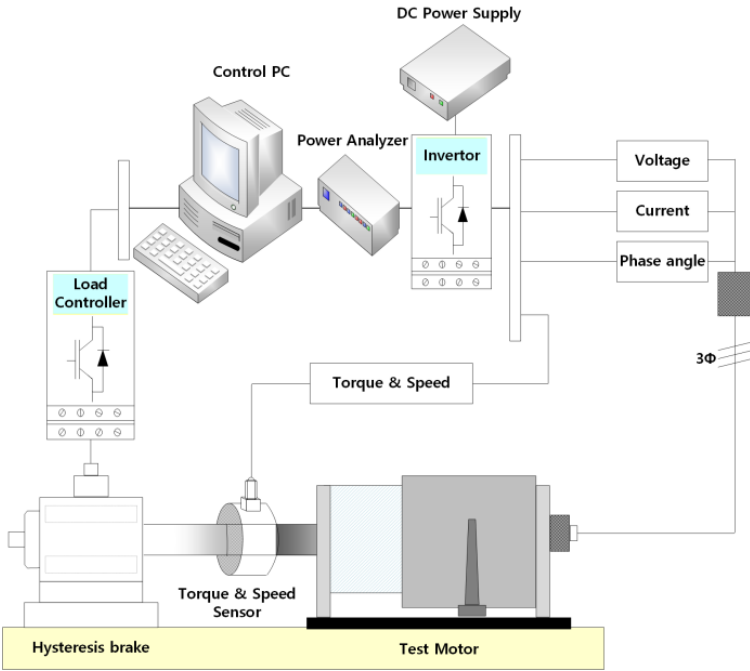
Figure 11. Concept of experimental system.